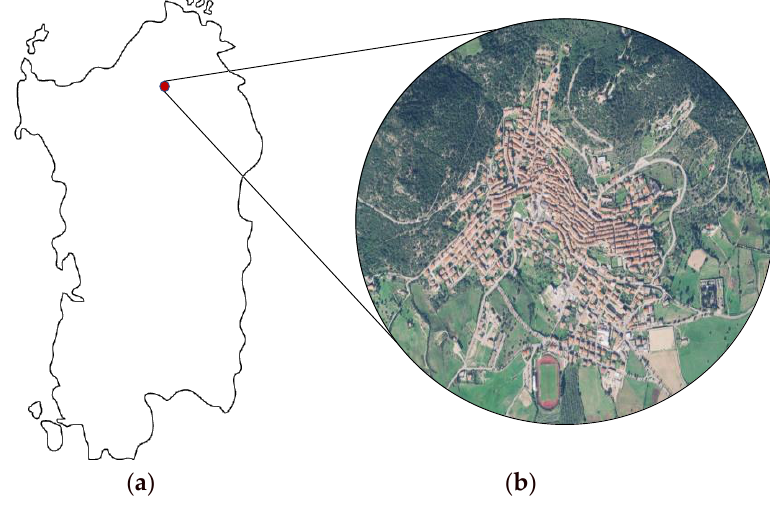
Figure 1. ( a ) Sardinia island ( b ) Municipality of Berchidda—Urban network.